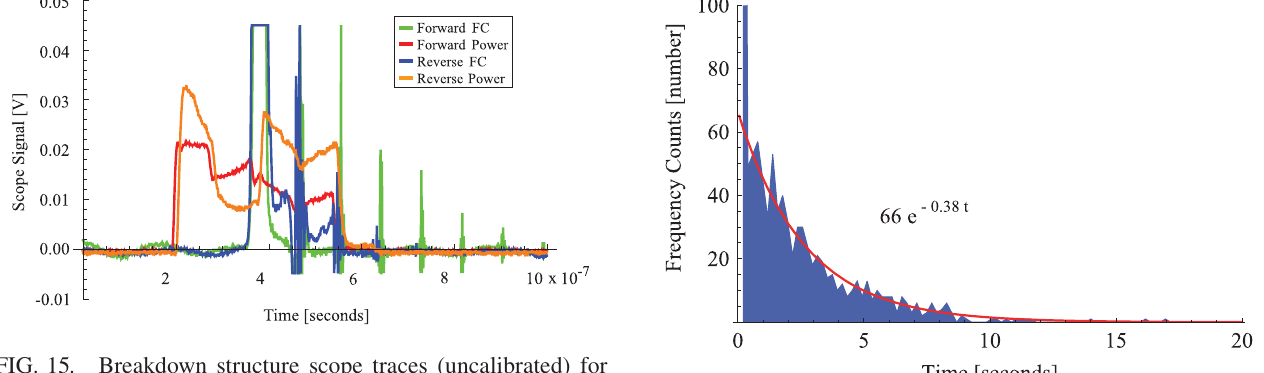
15. Breakdown structure scope traces (uncalibrated) for breakdown event. Forward and reverse power in structure, for- ward and reverse Faraday cup signals. After filling, the forward power into the structure (from the peak power meter) was 5.0 MW for 170 ns for this